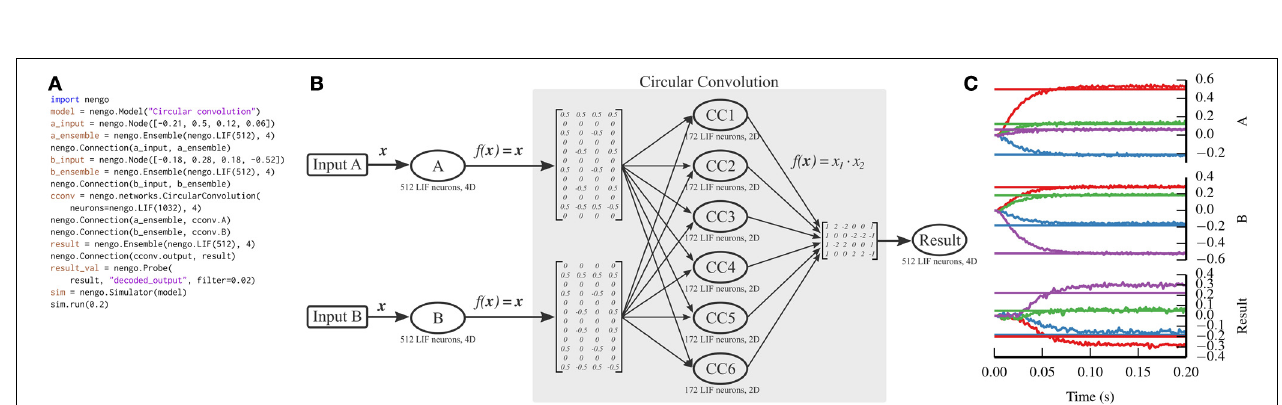
result. Note that the complicated parts of the model are contained within the network; the number of ensembles and the transform matrices shown are automatically generated by the network depending on the dimensionality of the input vectors. (C) The result of the simulation. Straight horizontal lines represent the target values that each ensemble should represent. Wavy lines represent the decoded values for each dimension represented by the A, B, and Result ensembles (top, middle, and bottom panels, respectively). The ensembles represent the correct values, after a startup transient of less than